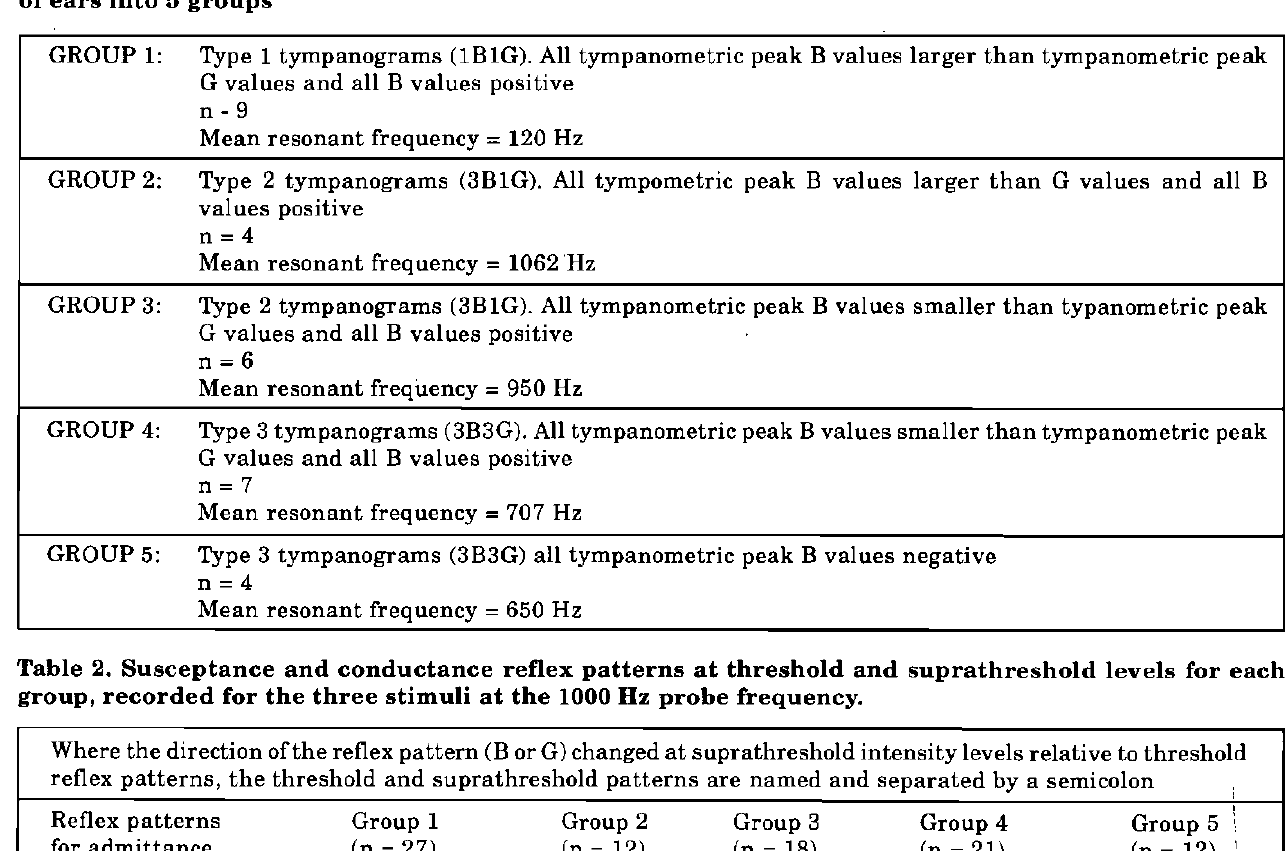
Table 1. Transmission propertie of ears at the 100 Hz probe signal which formed the basis for the division of ears into 5 groups